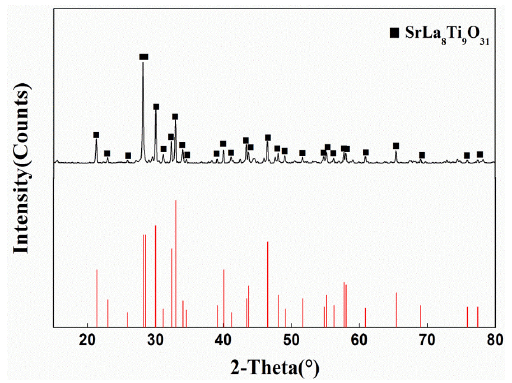
Figure 1. XRD pattern of La 0.9 Sr 0.1 TiO 3+ δ .